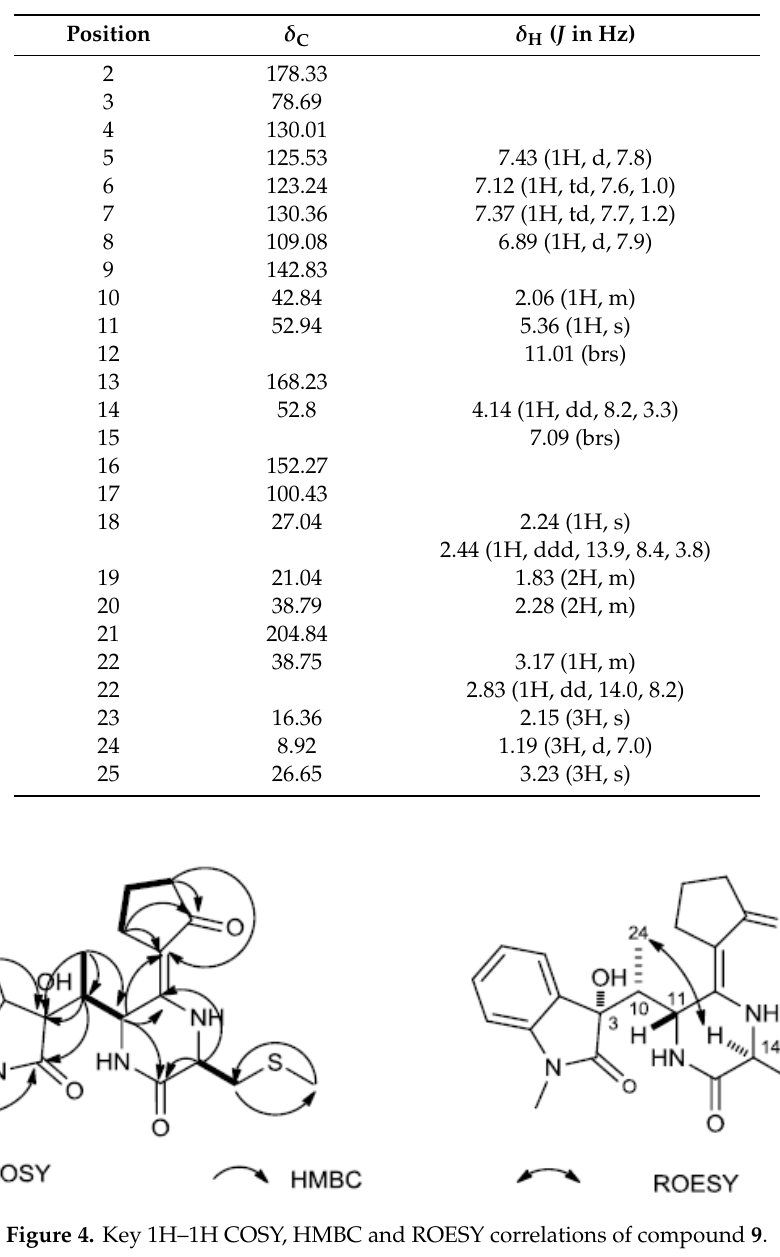
Table 3. EC 50 values of active compounds against S. sclerotiorum .